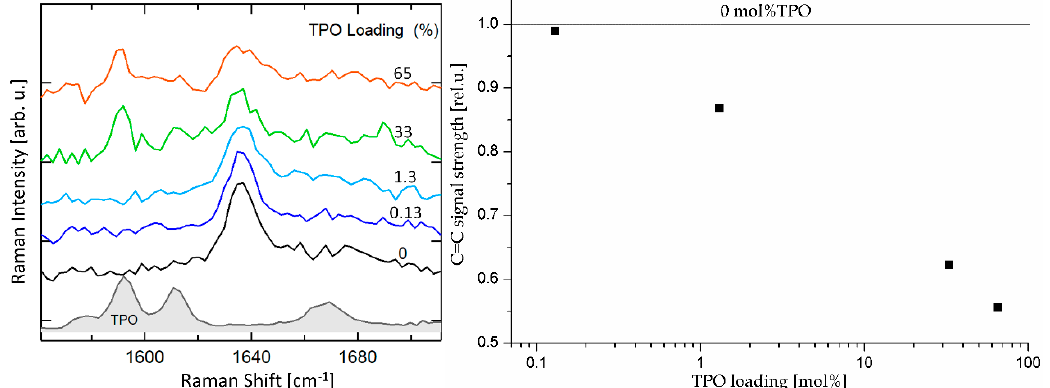
Figure 9. Raman analysis of the membranes. Left: Normalized Raman spectra of pVNB with varying TPO content and of UV treated TPO. The normalization was done similarly as for Figure 4. The CH x band region is shown in Figure S8. Right: C=C signal strength of Raman spectra plotted against the TPO content.